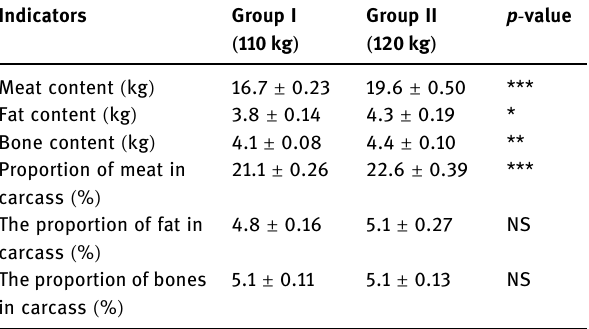
Table 3: Distribution of morphological composition of the dorsal - lumbar third of the carcass of pigs of the experimental groups ( n = 60 )